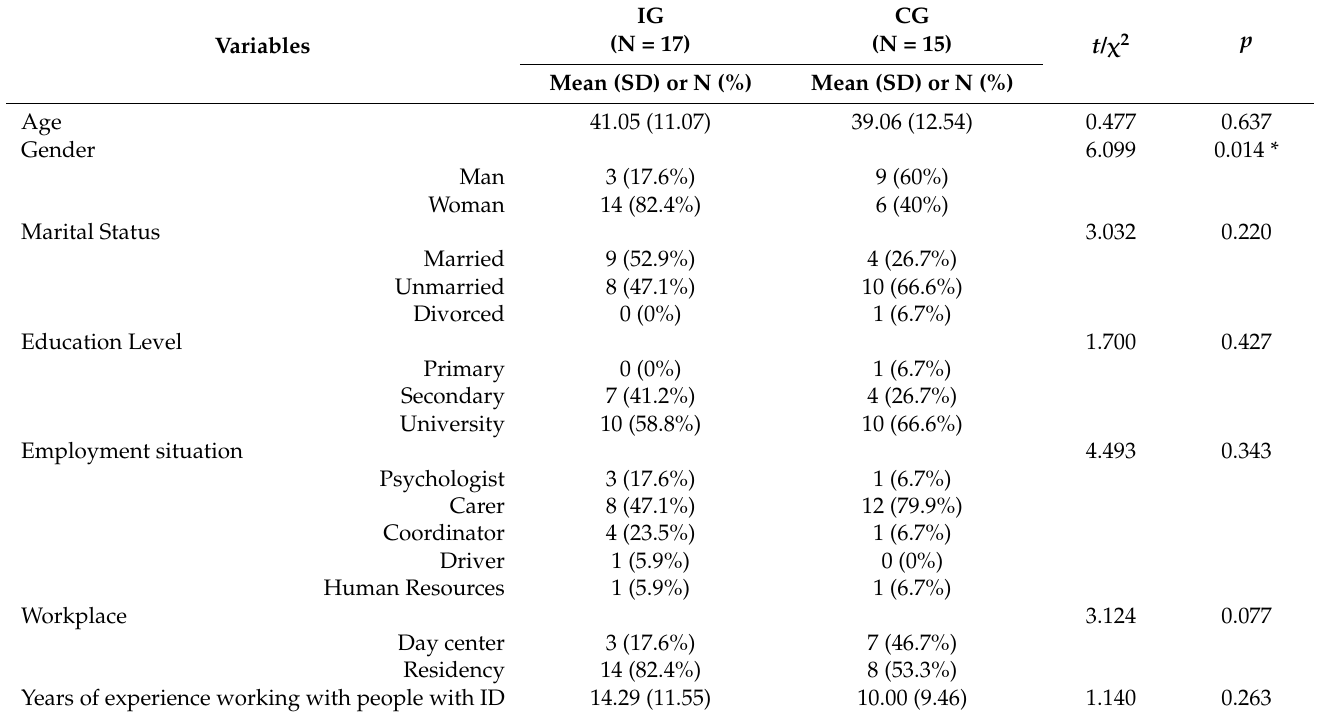
Table 1. Sociodemographic characteristics of the sample.